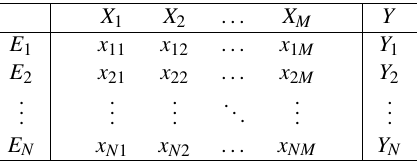
Table 1: Multi-label data X 1 X